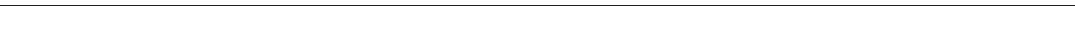
projections from entire time series (Min. Proj.); scale bar is 10 µ m. Right panels show corresponding kymographs; vertical scale bar is 10 µ m;